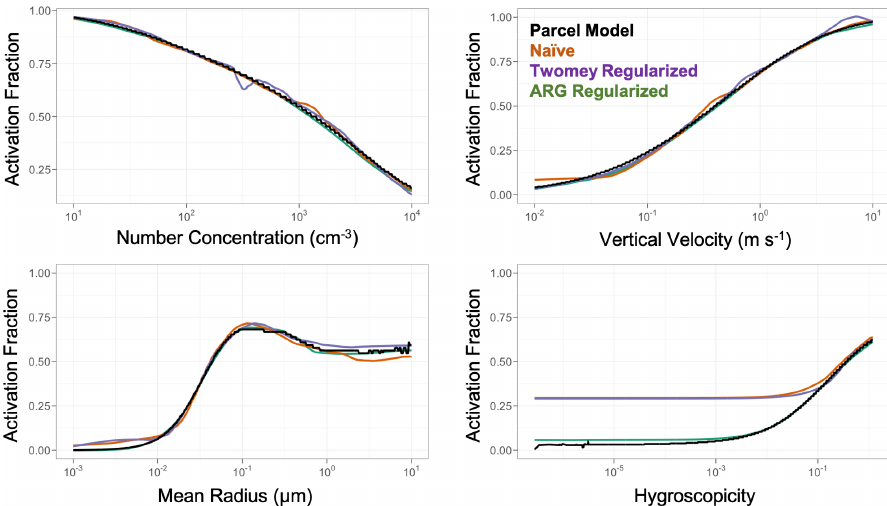
Figure 7. Variability in the predicted activation fraction from the DNN emulators and the parcel model as a function of input parameters. Number concentration, vertical velocity, mean radius, and aerosol hygroscopicity are shown here. The parcel model is shown in black, the naïve DNN emulator is shown in orange, the Twomey-regularized emulator is shown in purple, and the ARG-regularized emulator is shown in green. For each panel, all other parameters are fixed at the following settings: number concentration of 1000cm − 3 , mean radius of 0.05, aerosol mode standard deviation of 1.8, hygroscopicity of 0.54, vertical velocity of 0.5ms − 1 , temperature of 283K, pressure of 85000Pa, and an accommodation coefficient of